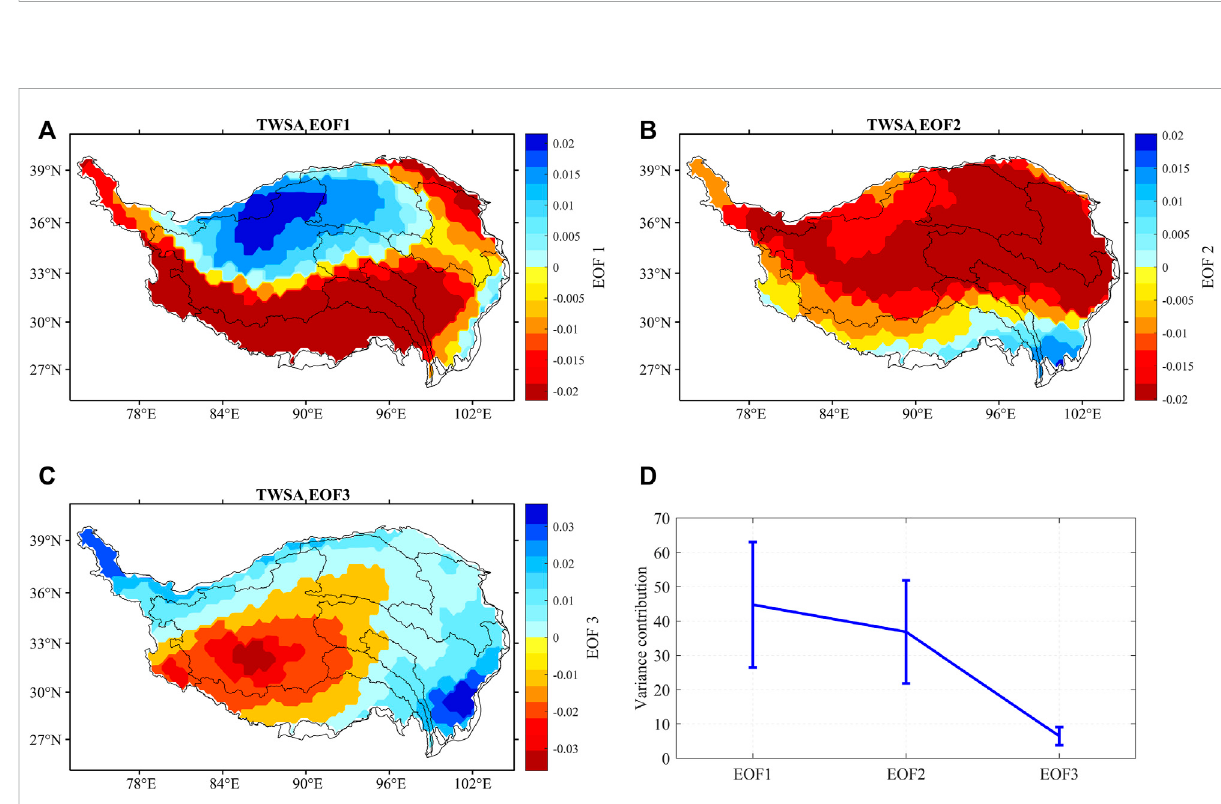
FIGURE 8 The spatial modes of TWSA in the Tibetan Plateau, (A) is EOF1, (B) is EOF2, (C) is EOF3, and (D) is variance contribution rate and error bar using the North test.